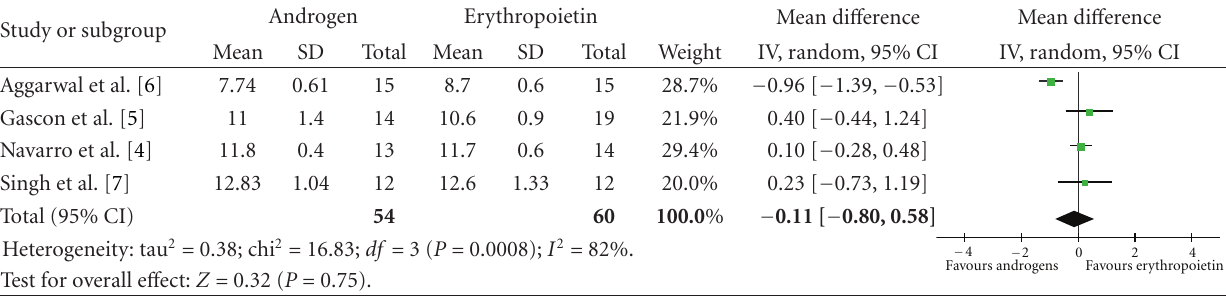
Table 2: Mean haemoglobin at the end of the trials.